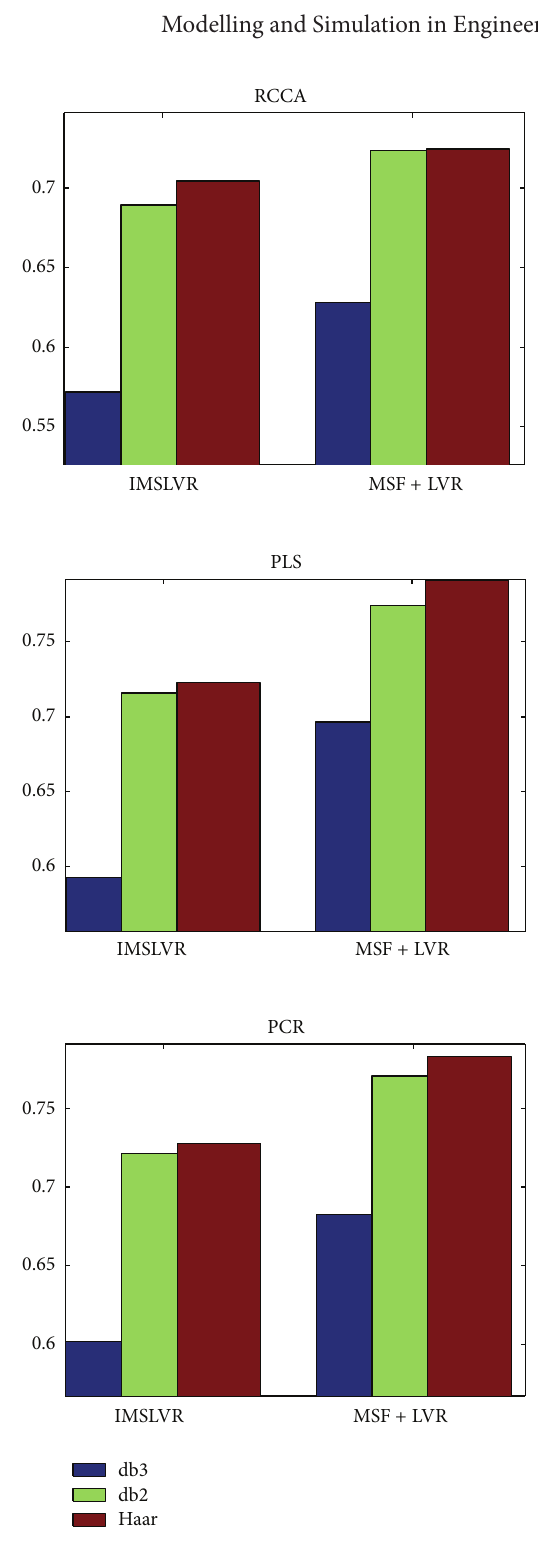
Figure 5: Comparison of the MSEs for various wavelet filters in example 1 for the case where SNR = 10